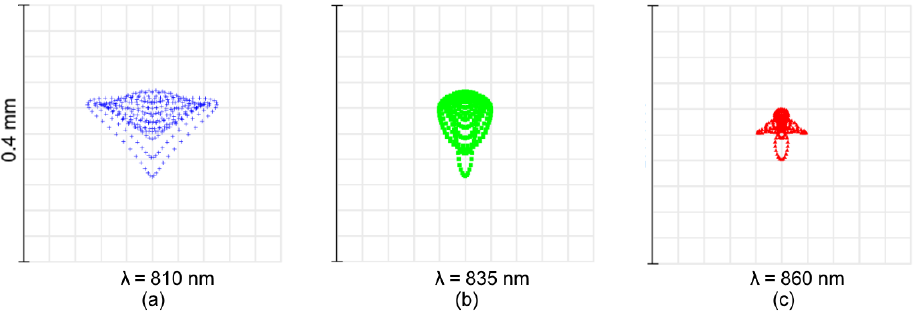
Figure 6. Spot diagrams of the high-dispersion spectrograph Design A.